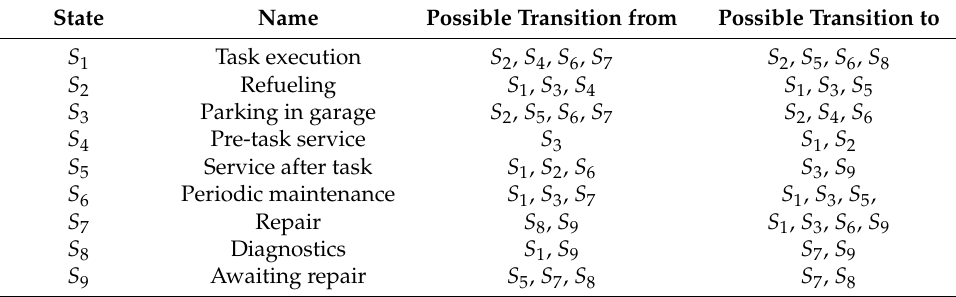
Table 2. State space of the light utility vehicles operation process.